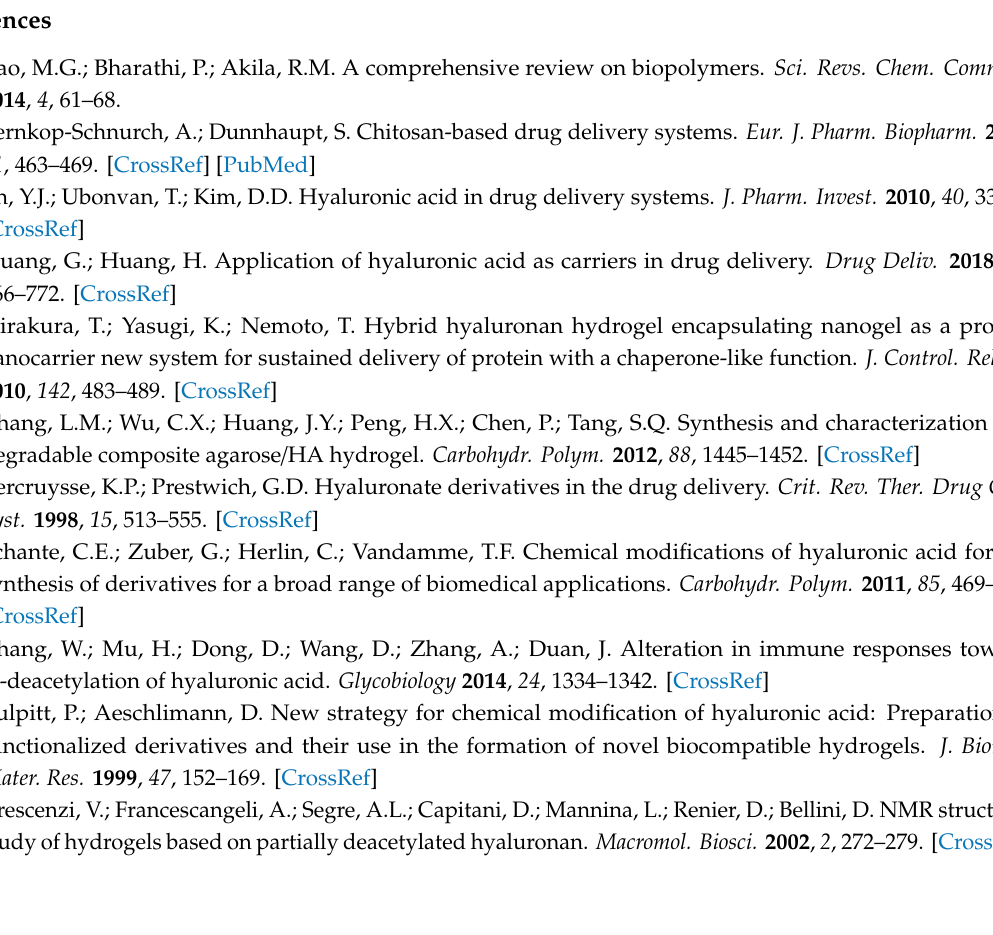
of monotosylation of β -CD, Figure S2: DOSY spectrum of CD-HA, Figure S3: 1 H-NMR spectrum of CD-HA, Figure S4: SEC results of original hyaluronan (HA, 4 ), oxidized hyaluronan (OX-HA, 5 ), propargylated hyaluronan (Prop-HA, 6 ), and final hyaluronane modified by β -CD units (CD-HA), Figure S5: Stacking plot of portions of the 1 H-NMR spectra recorded within the titration of G2 with CD-HA (D 2 O, 30 ◦ C), Figure S6: Stacking plot of portions of the 1 H-NMR spectra recorded within the titration of G3 with CD-HA (D 2 O, 30 ◦